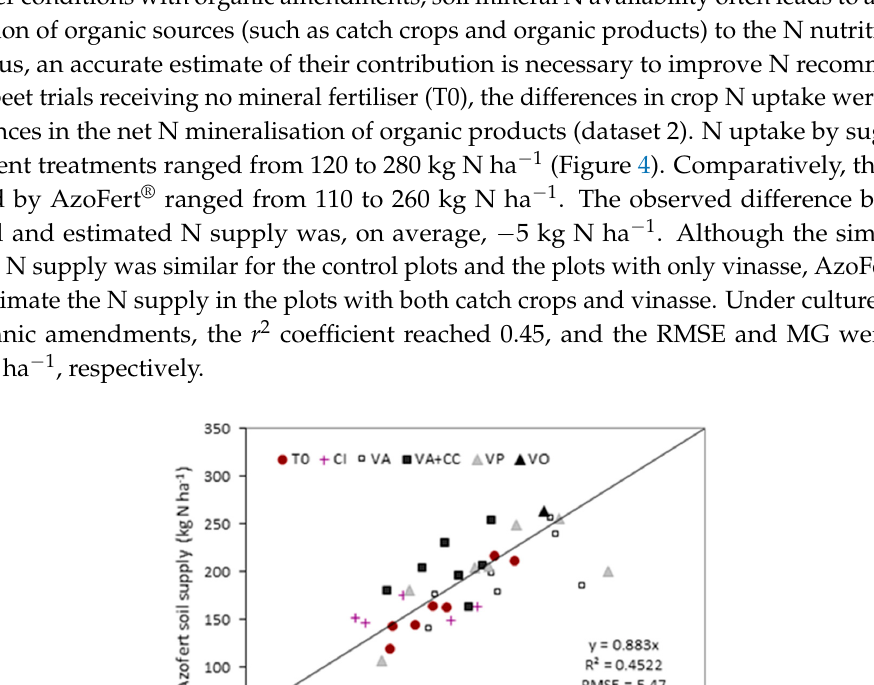
Figure 3. Comparison of the N uptake by plants in the control plots (no fertiliser) and the N supply estimated using AzoFert ® software. The 133 data points include several crops (winter wheat, winter and spring barley, and field vegetables).